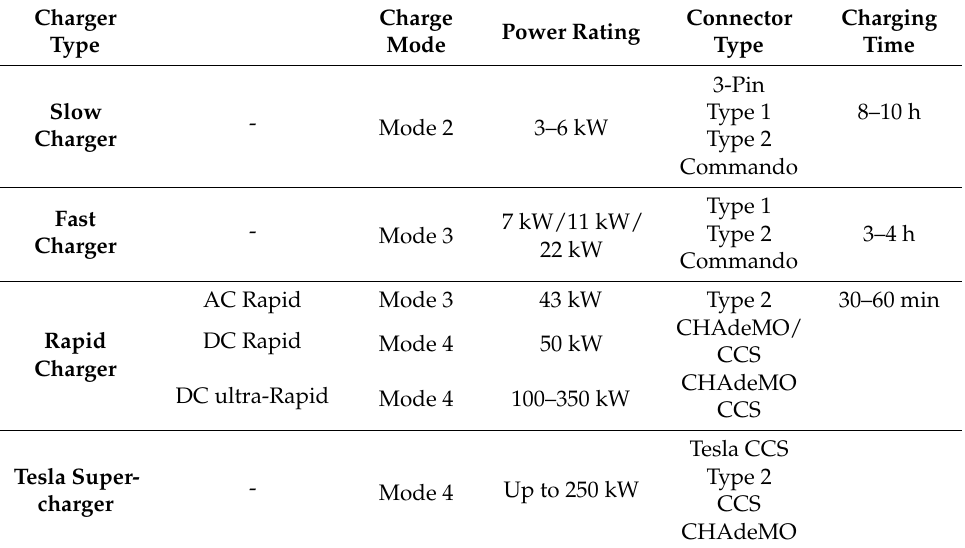
Table 5. EV charging parameters in the